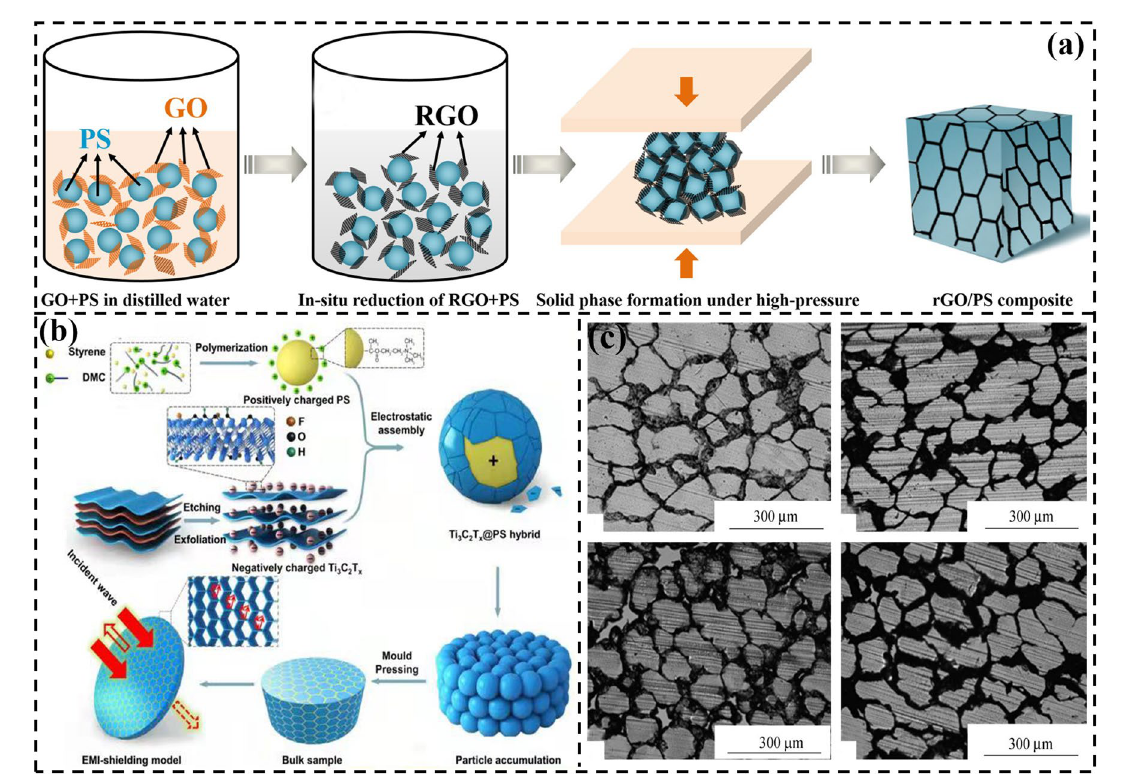
Fig. 7 Schematic illustrating the fabrication of a rGO/PS and b MXene@PS composites [96, 97]. c SEM images of CB/UHMWPE composites [95]. Copyright © 2014 Wiley–VCH. Copyright © 2017